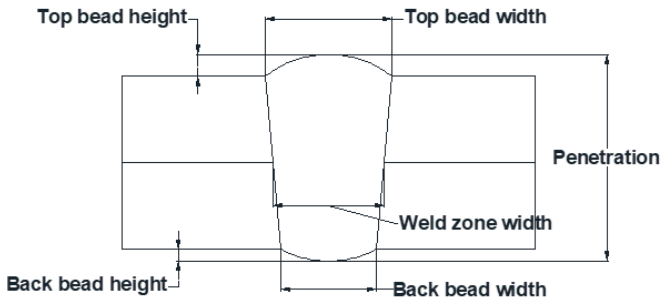
Figure 13. Sectional observation measurement location. Table 6. Sectional observation measurement result.